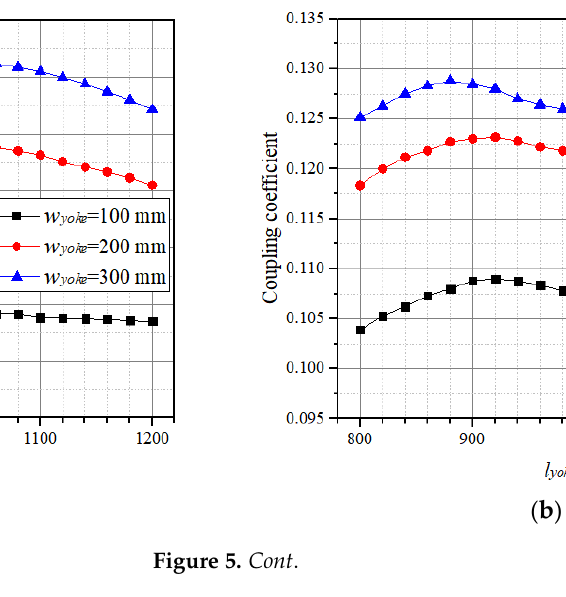
Table 1. The design case of the dual-phase NSP